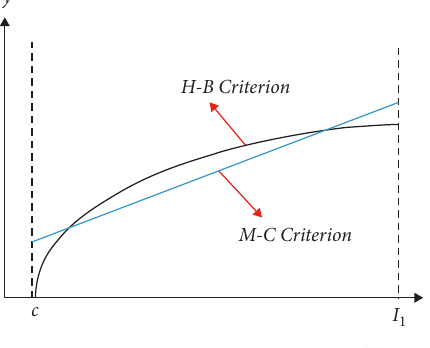
Figure 5: Area equivalent of the I